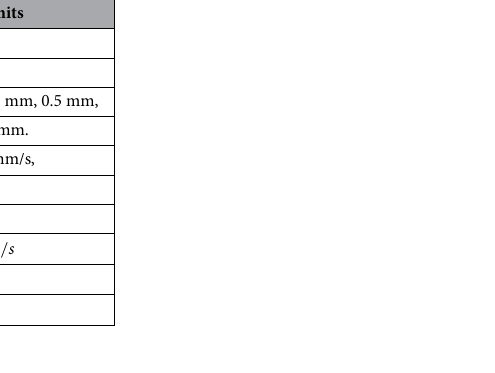
Table 3. Parameters for